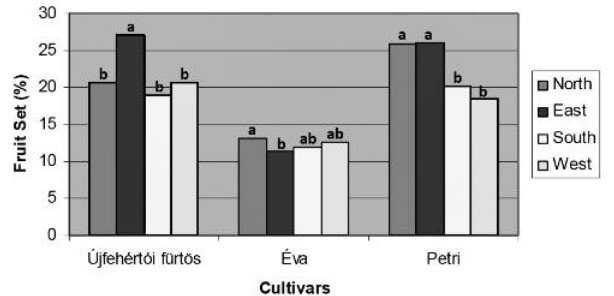
Figure 2B. Fruit set of sour cherry cultivars on different direction of the tree